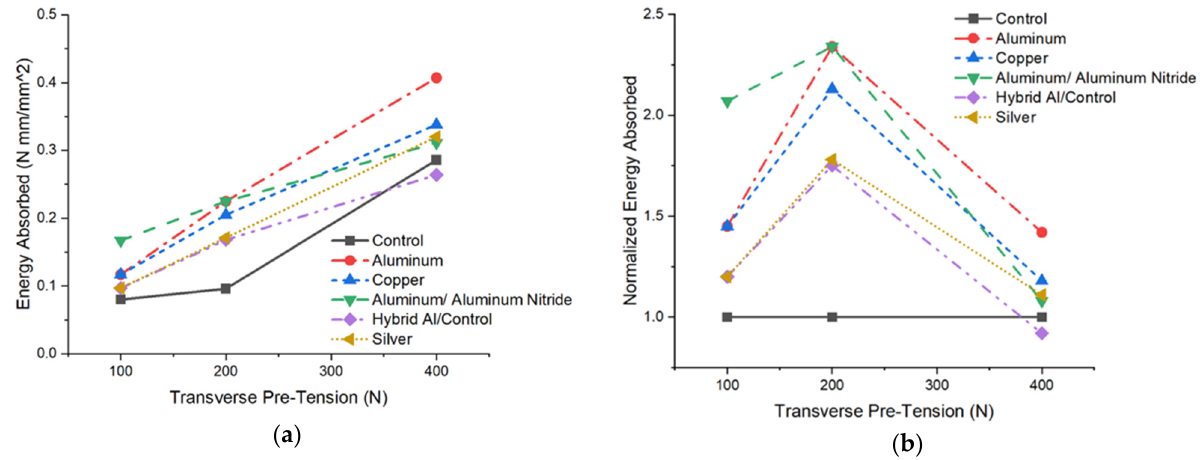
Figure 12. Effect of transverse pre ‐ tension on ( a ) energy absorbed ( b ) normalized energy absorbed.